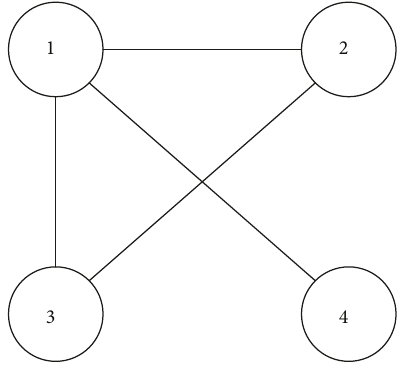
Figure 6: The trajectories of x symmetric time delays when all τ m > τ up